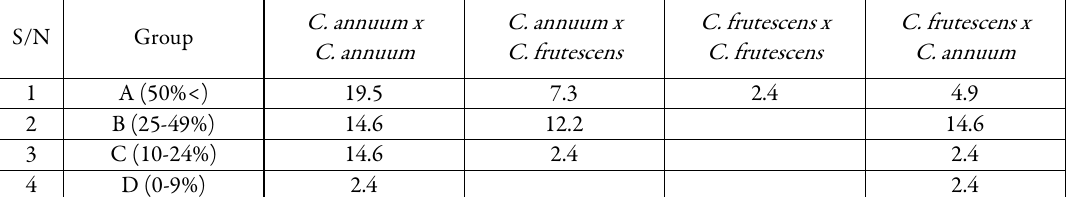
Table 2. Percentage success